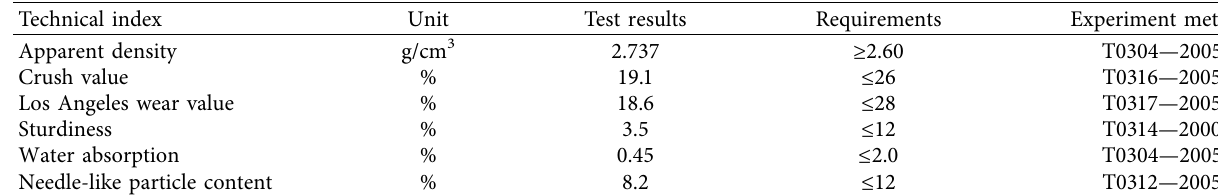
Table 11: Limestone coarse aggregate performance index.